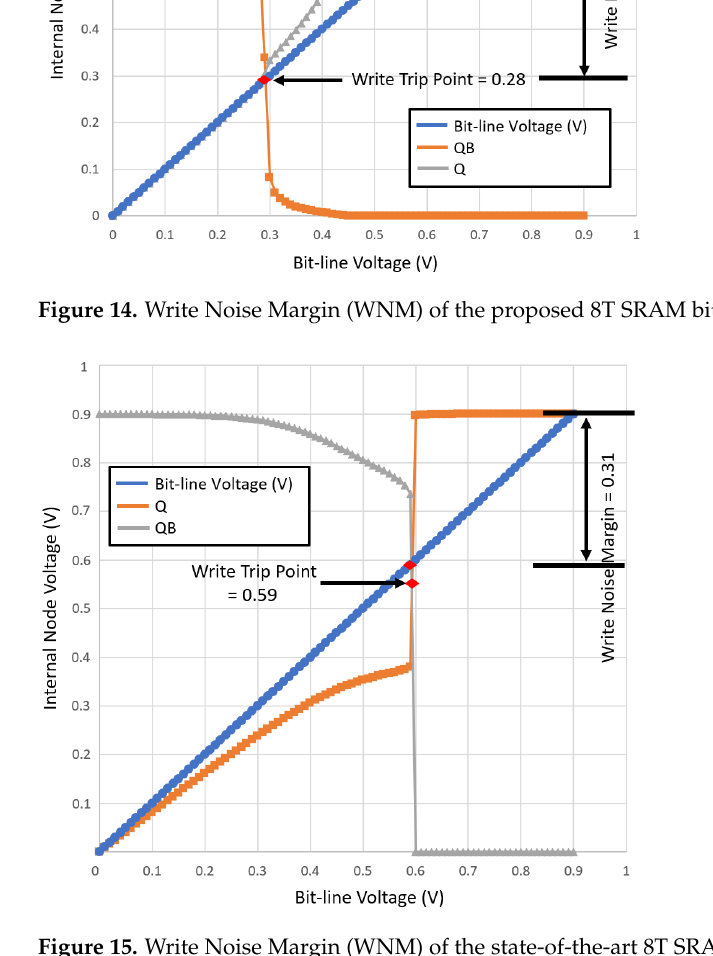
Figure 15. Write Noise Margin (WNM) of the state-of-the-art 8T SRAM bit